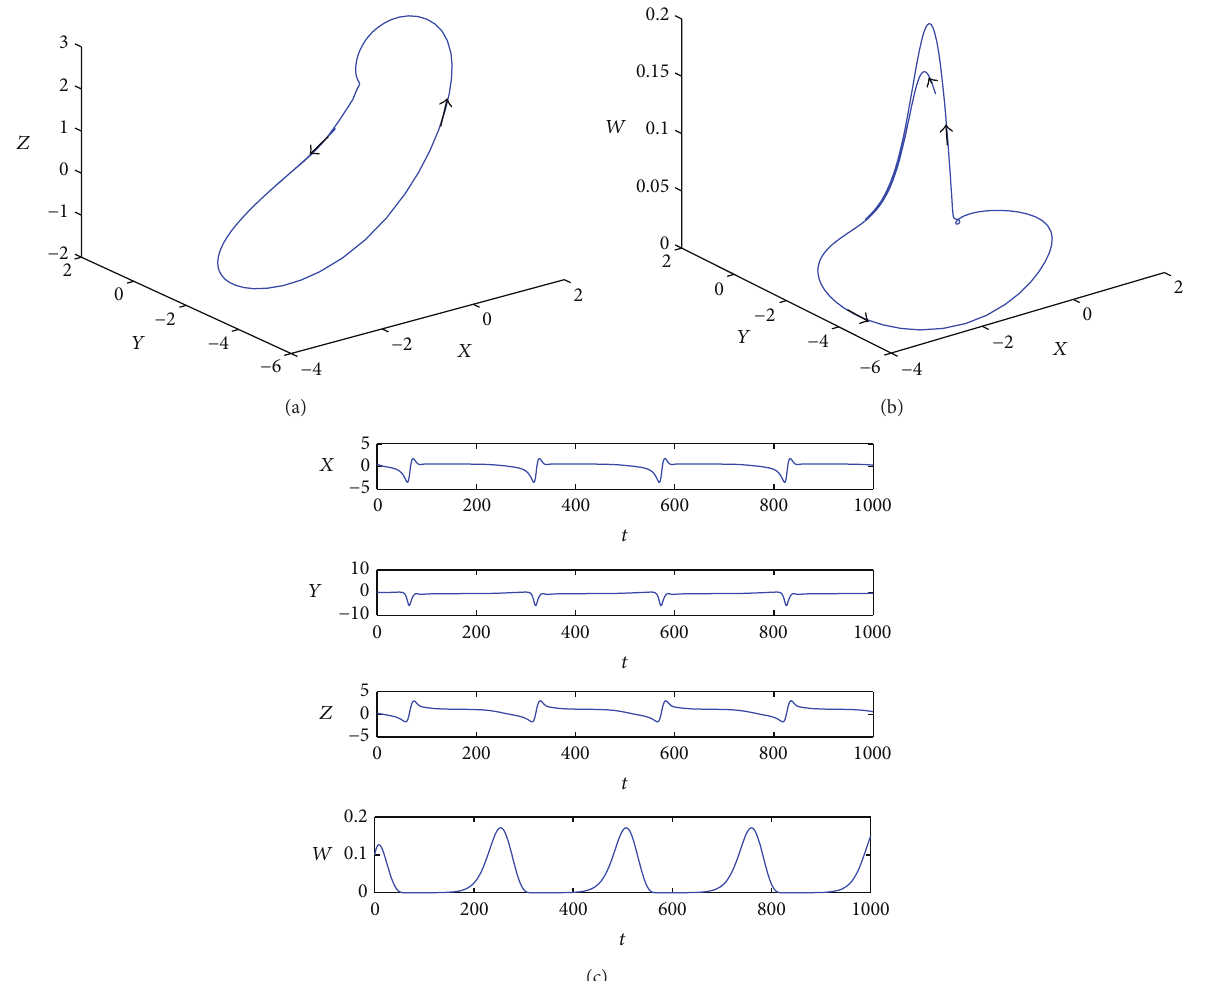
Figure 2: A limit cycle of system (1): (a) a 3D view ( 𝑋 - 𝑌 - 𝑍 ), (b) a 3D view ( 𝑋 - 𝑌 - 𝑊 ), and (c) the time series of 𝑋(𝑡),𝑌(𝑡),𝑍(𝑡), 𝑊(𝑡)